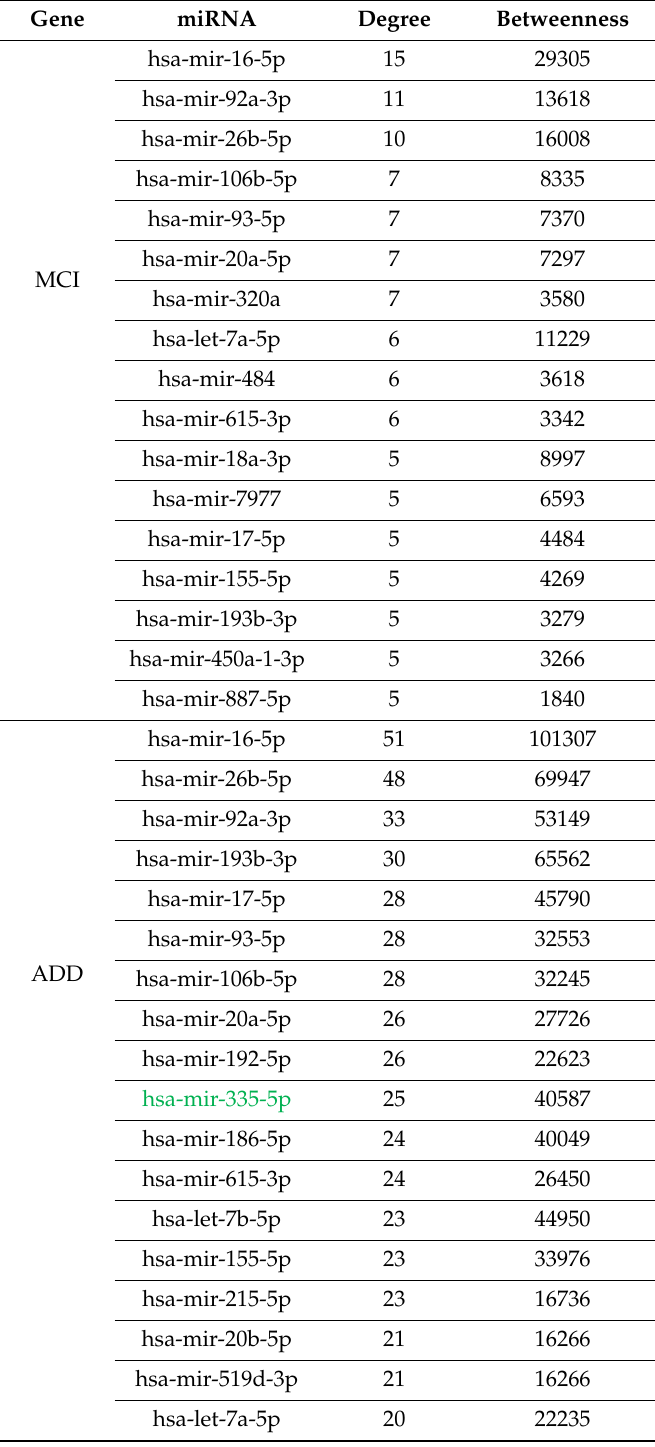
Table 2. MicroRNA